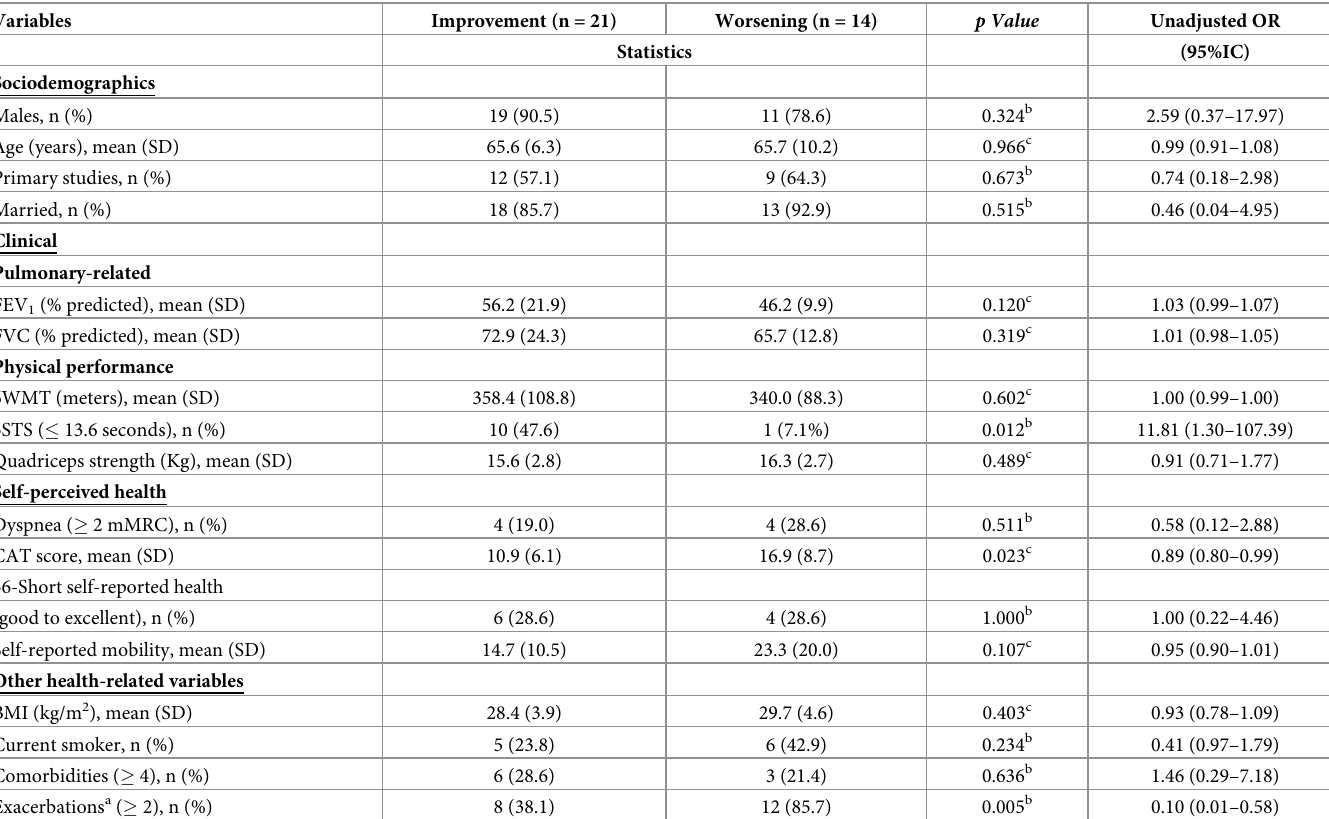
Table 3. Chi-square and Odds Ratio (Unadjusted) values of covariates between improvement and worsening groups (n =